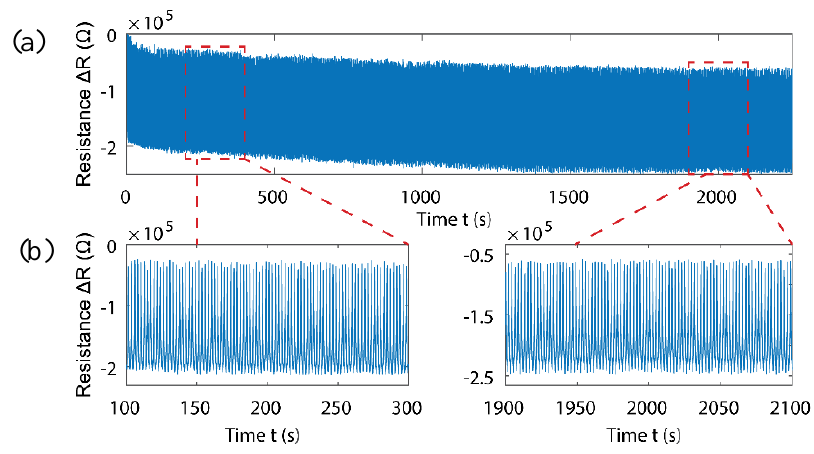
Figure 8. ( a ) Complete 1000-cycle test, ( b ) two graphs show more detailed start and end of cycle test.